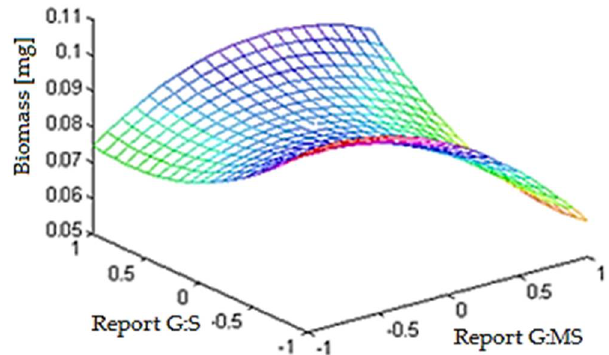
Figure 2. The influence of the report between glucose and starch and the report between glucose and modified starch when the time of the development of biomass is maintained in the field centers .